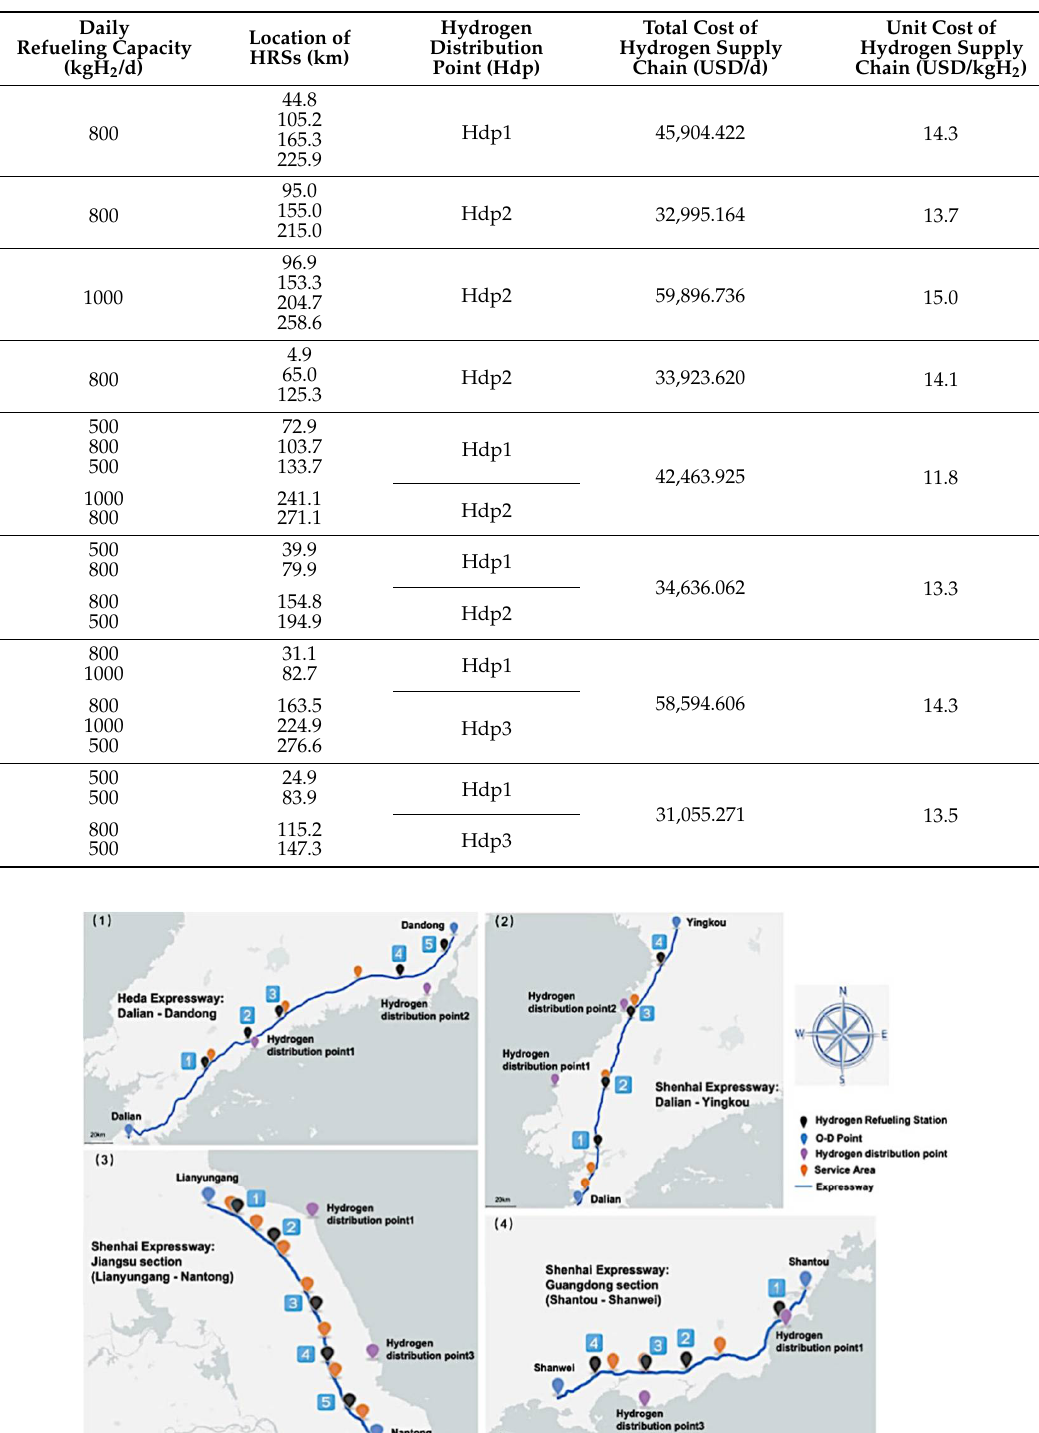
Table 11. Summary of hydrogen distribution points and hydrogen refueling stations.